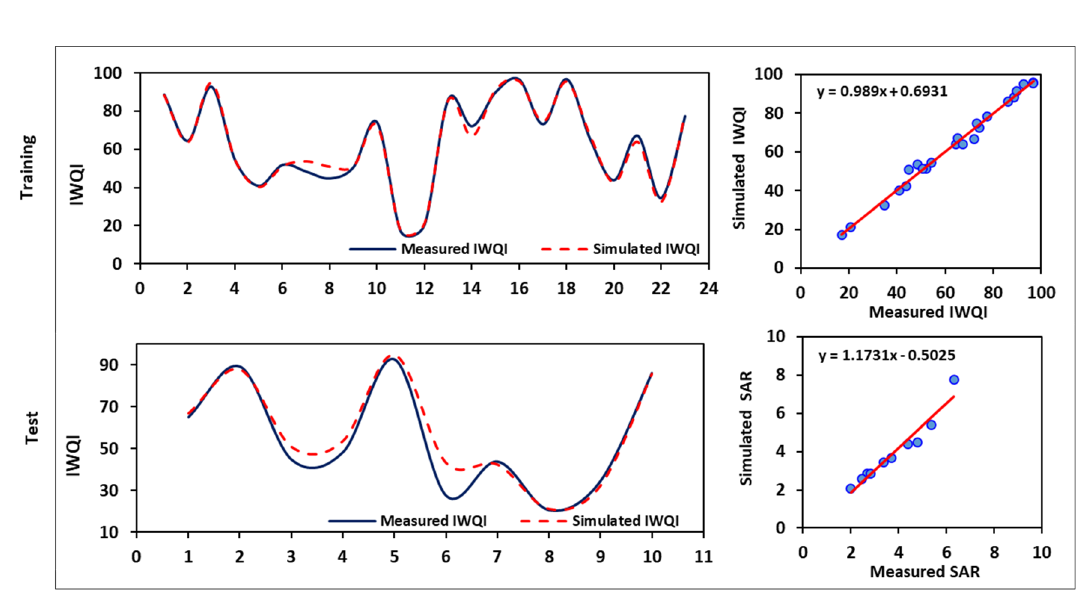
Figure 15. Results of the ANFIS model-based simulated IWQI.